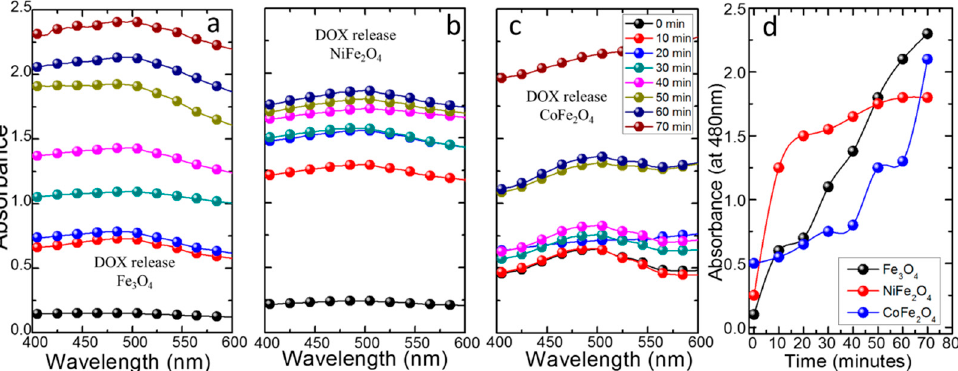
Figure 3. Time-dependent DOX release from the PEG coated magnetic nanoparticles based nanofluids ( a ) Fe 3 O 4 , ( b ) NiFe 2 O 4 , ( c ) CoFe 2 O 4 , ( d ) Absorbance at 480 nm. The plots representing the cumulative DOX release % versus time, a log of cumula- tive drug unreleased versus time, cumulative DOX release % versus square root of time and log cumulative Dox release % versus log Time, for the PEG coated CoFe 2 O 4 , PEG coated NiFe 2 O 4 and PEG coated Fe 3 O 4 MNFs are shown in Figure 4 respectively.